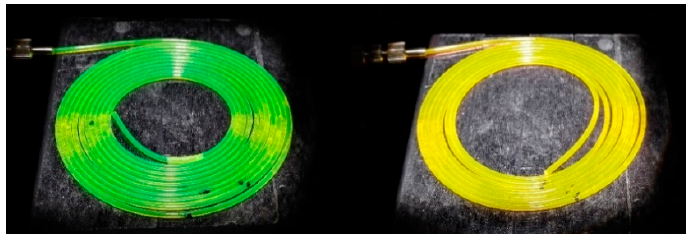
Figure 8. Photograph of two of the samples rolled into several loops under the solar simulator excitation.